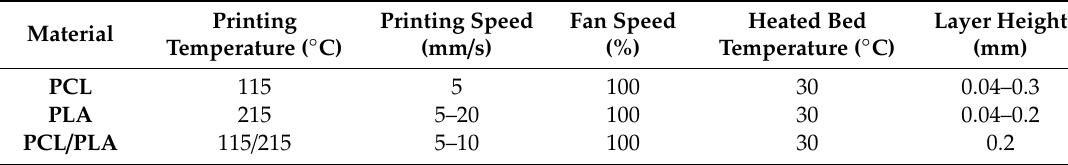
Table 1. Printing parameters for the prepared